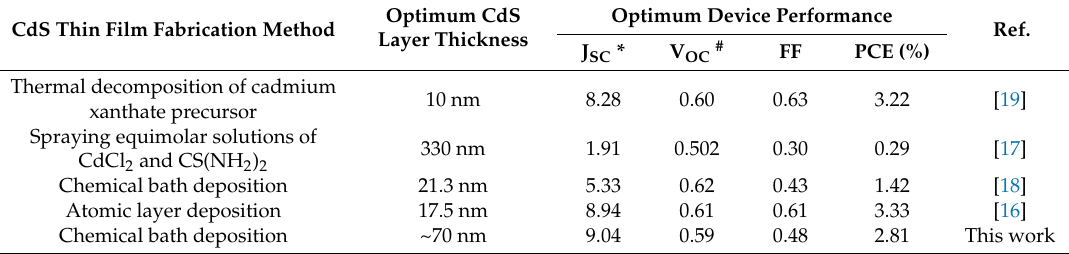
Figure 4. Variation of PV device properties of ITO/CdS/PCBM:P3HT blend/PEDOT:PSS/MoO 3 /Ag devices with different CdS deposition times. Table 1. Comparison of P3HT:PCBM BHJ solar cells with the CdS hole-blocking layer fabricated by different